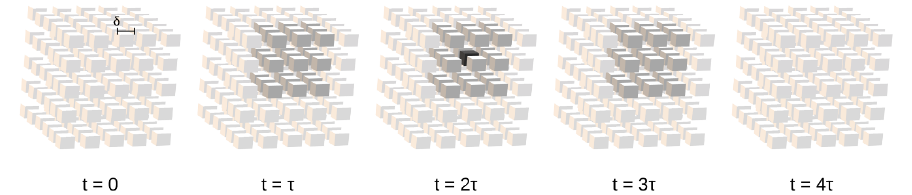
Figure 8. A 4D grid representation of the airspace. The dark grey cells would be the neighboring cells of the black